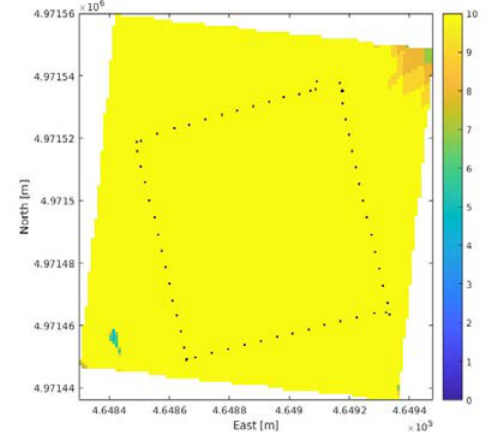
Figure 8. Camera location of the oblique survey (black dots) and image overlapping (colour bar).